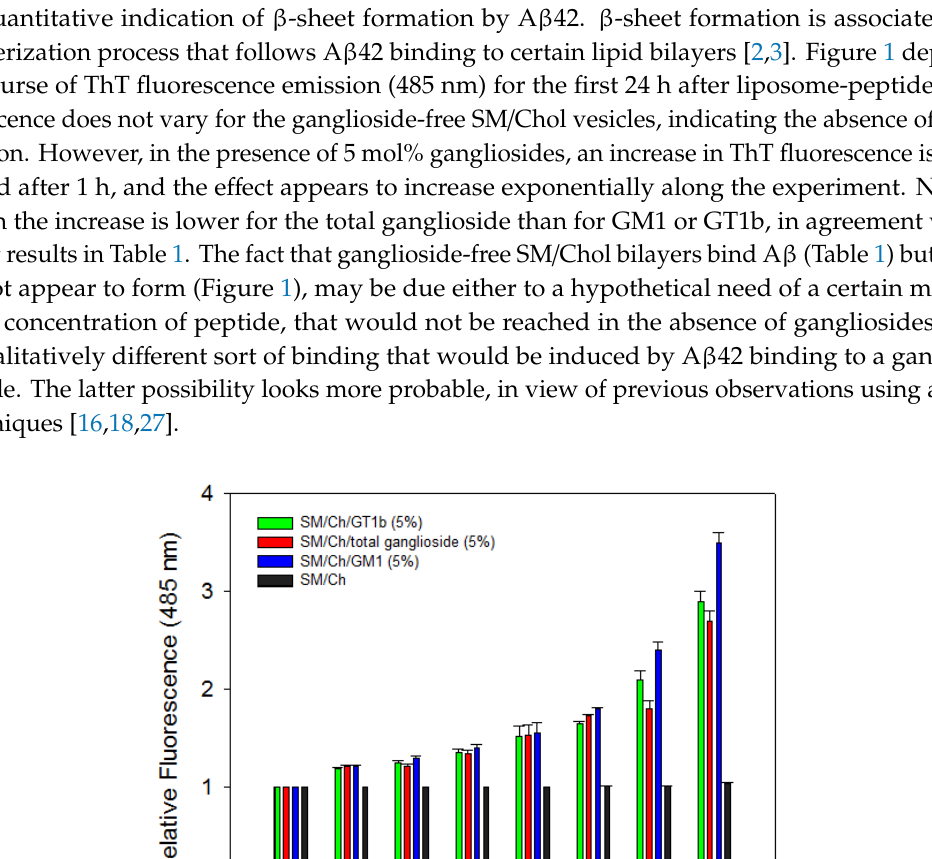
Table 1. Binding of Aβ42 to sphingomyelin/cholesterol vesicles in the presence or absence of gangliosides: Flotation assay. Percent distribution of peptide in the various gradient fractions: F1, F2, F3, F4 from bottom to top of the centrifuge tube. L, fraction obtained from washing the tube walls with SDS. Average values ± S.E. (n. d. = not detected).